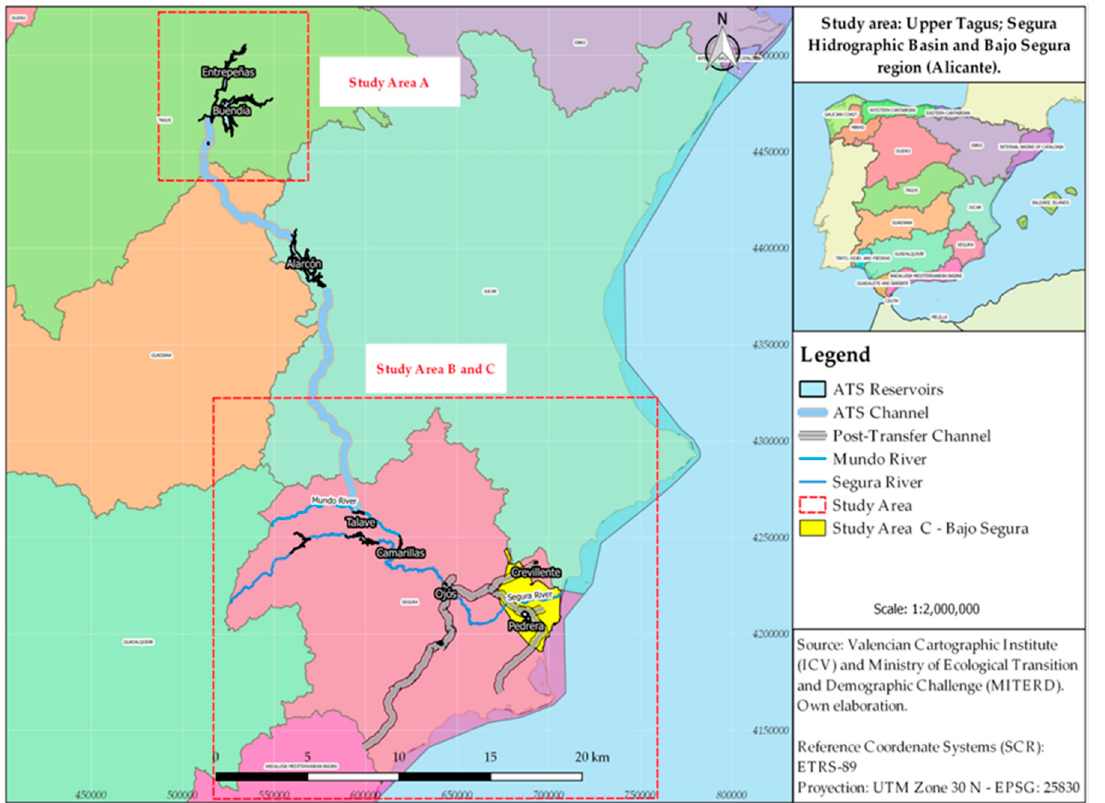
Figure 2. Study area: ( A ) Upper Tagus; ( B ) Segura Hidrological Basin; and ( C ) Bajo Segura Region (Alicante). Source: Valencian Cartographic Institute (ICV) and Demarcación Hidrográficadel Tajo (DHT) and Segura (DHS). Own elaboration.